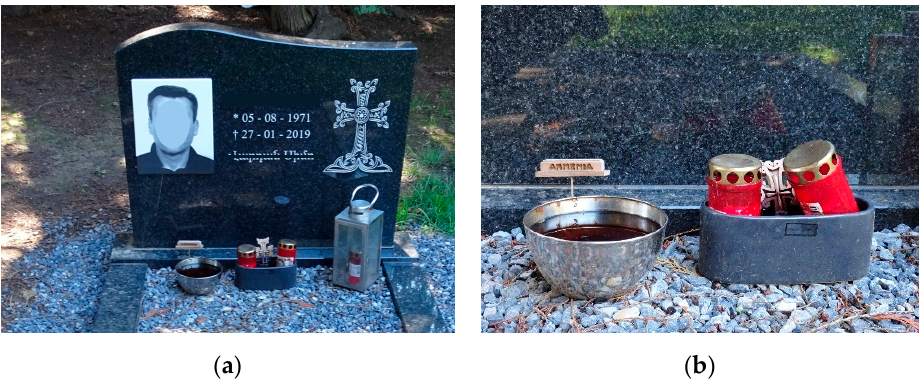
Figure 9. ( a , b ) Details of the first Armenian grave on the plot allocated to the Armenian Apostolic Community in Maastricht (photographs: M.W.).